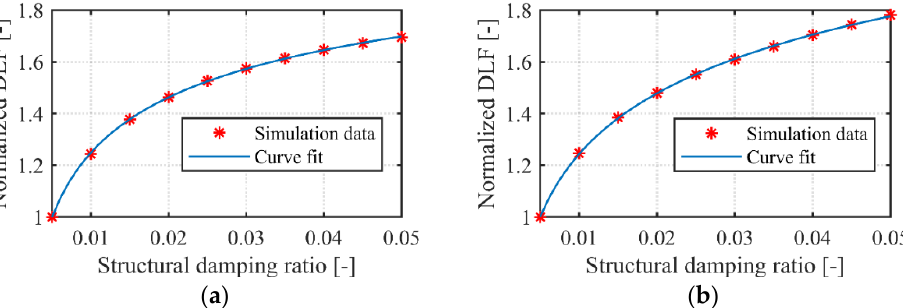
Figure 5. Conversion model for structural damping ratio. ( a ) Model for the first harmonic, ( b ) Model for the second